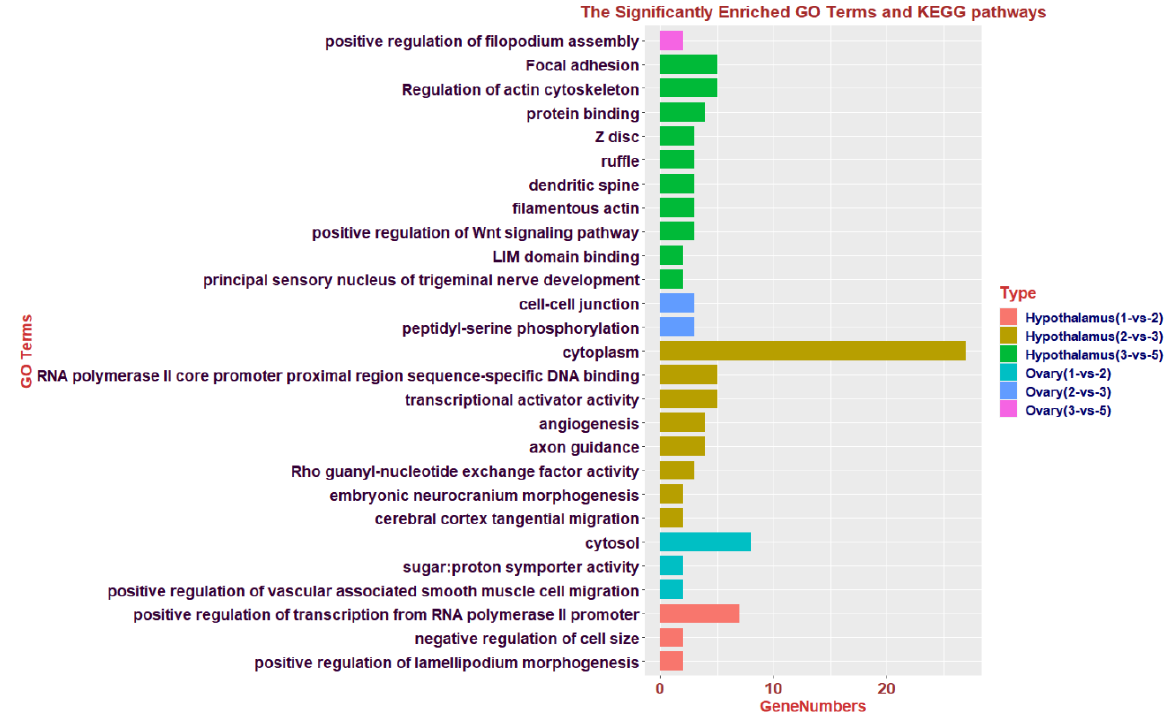
Figure 4. GO terms and KEGG pathways in DMGs from six groups.